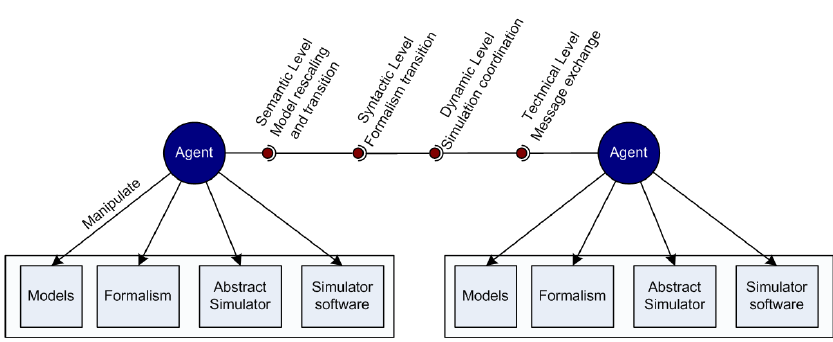
Figure 10. Interaction among Agents in the AA4MM meta-model (adapted from [14]).